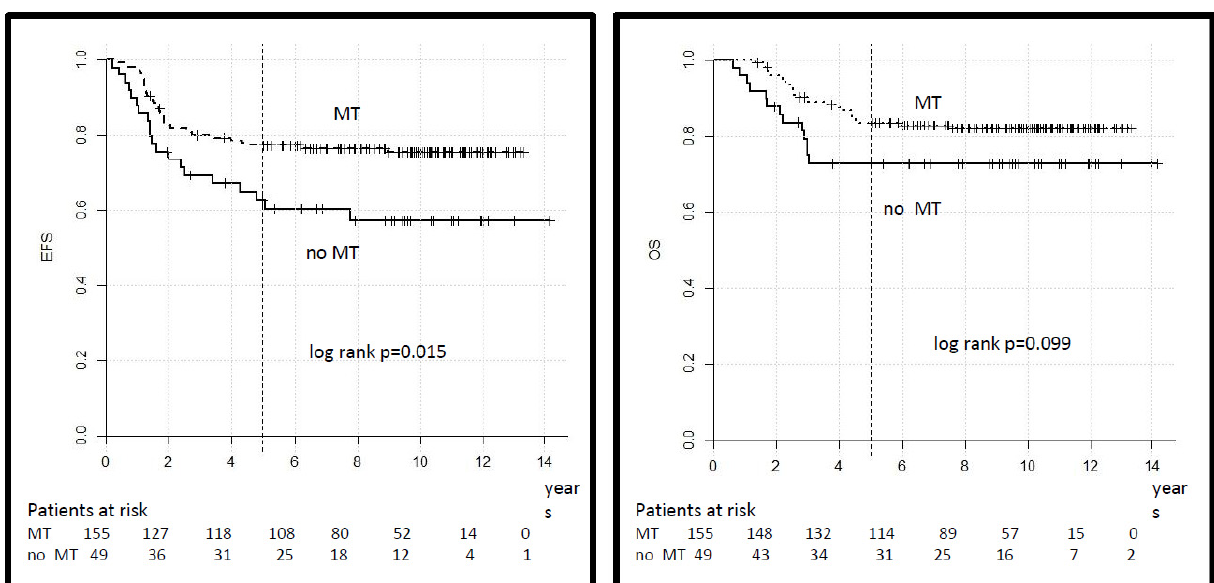
Figure 5. Legend: event-free and overall survival for patients in the HR group according to treatment with maintenance therapy (MT).